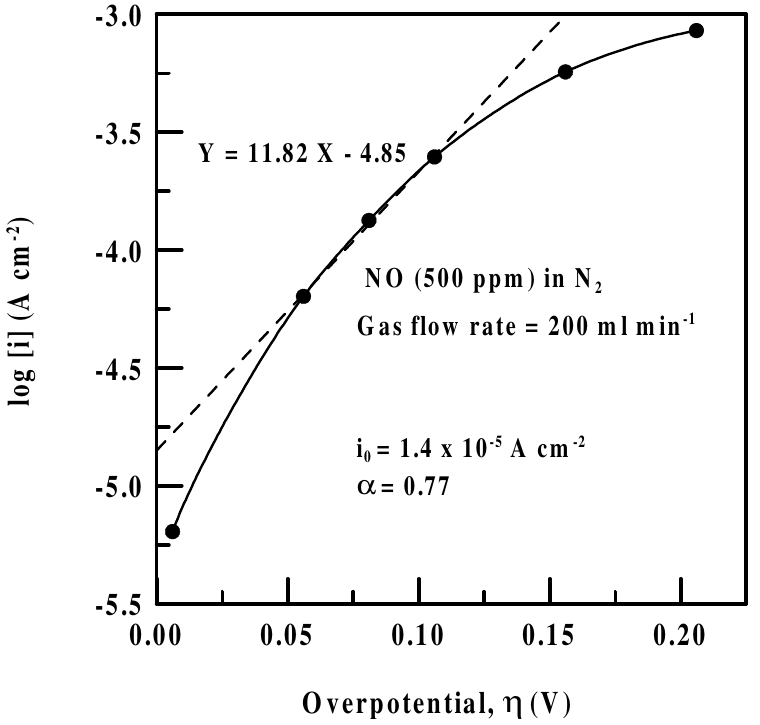
Figure 6 . A plot of log [i] vs. overpotential in the kinetic controlled region. The slope gives the value of a and the intercept gives the value of i o